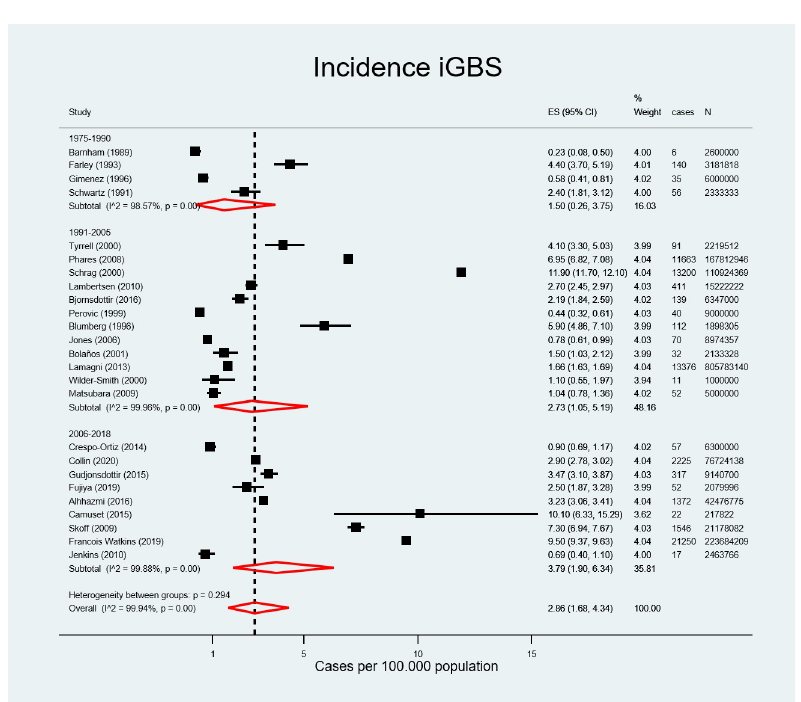
Fig 3. Pooled estimated incidence of invasive group B streptococcal infection by period.